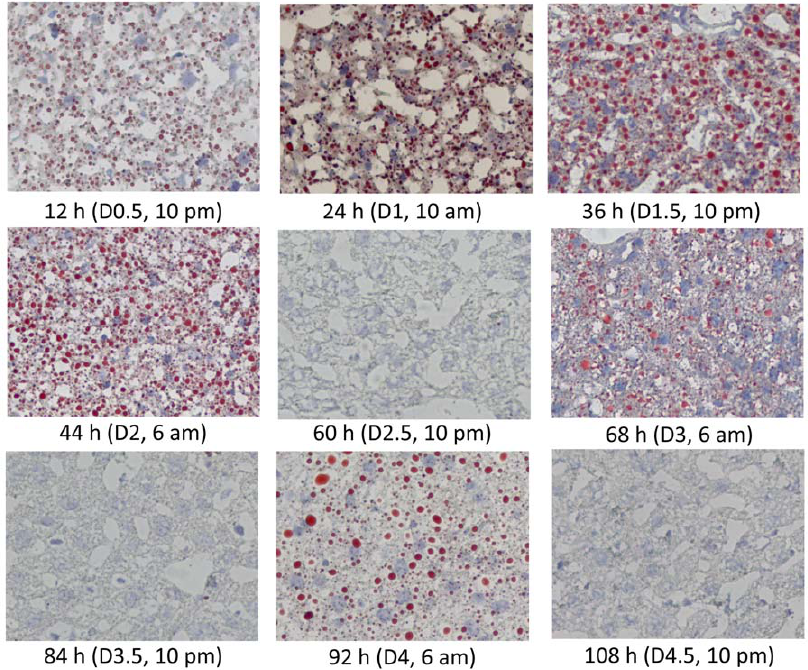
Figure 8. Hepatic fat accumulation in regenerating livers. Livers were isolated at the indicated time points from mice that underwent partial hepatectomy. Frozen liver sections were prepared and used for Oil red O staining (200 6 original magnification).